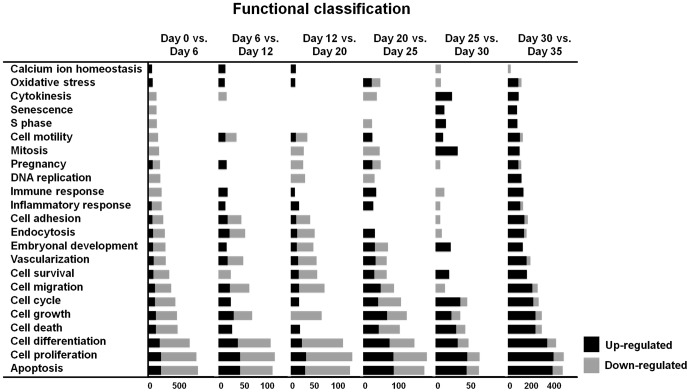
Functional categorization of differentially expressed genes found to be associated with cellular and molecular functions.Genes that changed significantly were assigned to various functional annotations related to cellular processes based on Gene ontology annotation.